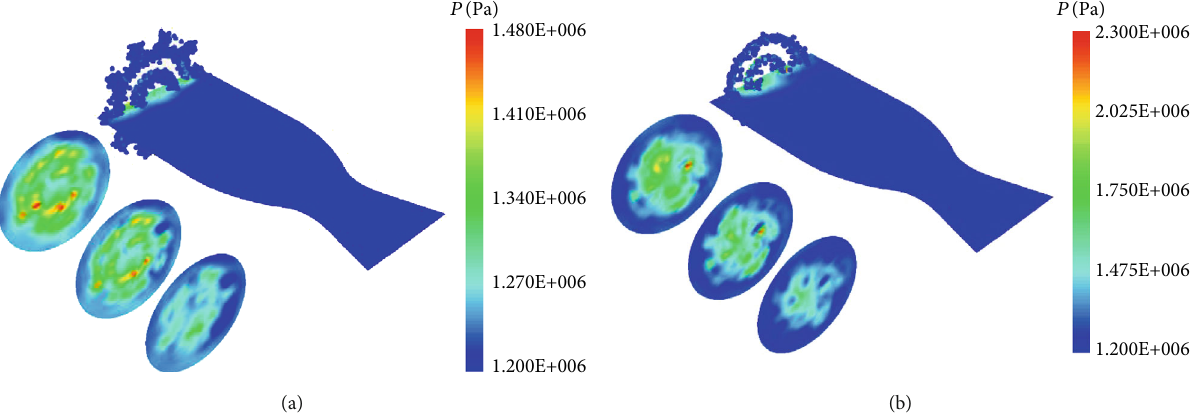
Figure 14: The acoustic pressure contours in Case 2. (a) 7.51051ms, MMH. (b) 8.33989ms, NTO.